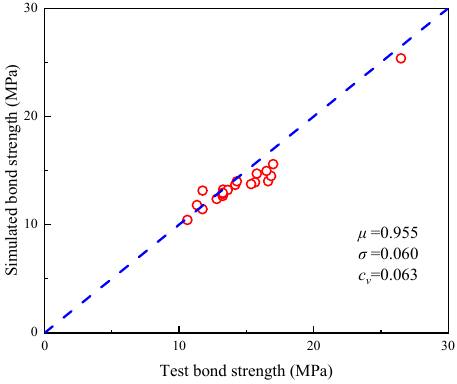
Figure 16. Comparison of bond strength between test and simulation.